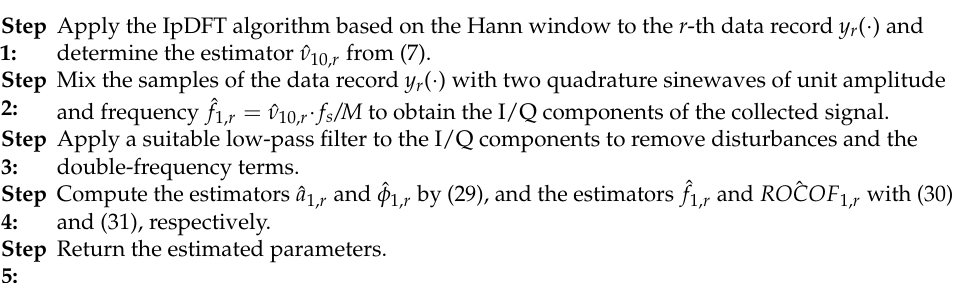
Table 3. Steps of the tuned DCF estimation algorithm for